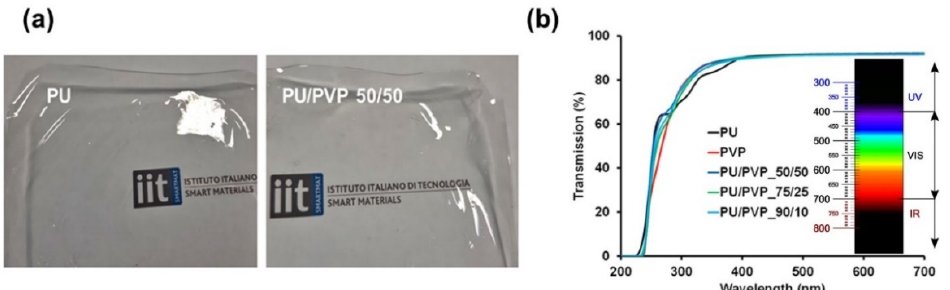
Figure 1. ( a ) Photographs of a transparent films comprising 100% PU (left) and PU/PVP_50/50 (right), ( b ) UV ‐ Vis spectra of the blend films including pure PU and PVP polymers. The inset shows the UV ‐ Vis spectrum extending into the IR region.